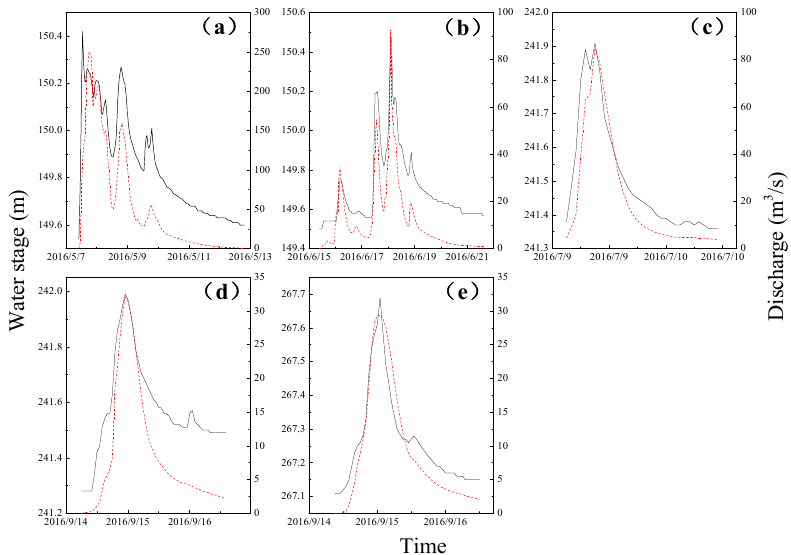
Figure 6. Verification results of five flash flood events using river water stage data: ( a ) Verification result of Zhengfang 20160508 event; ( b ) Verification result of Zhengfang 20160618 event; ( c ) Verification result of Renshou 20160709 event; ( d ) Verification result of Renshou 20160915 event; ( e ) Verification result of Zhongyutian 20160915 event.